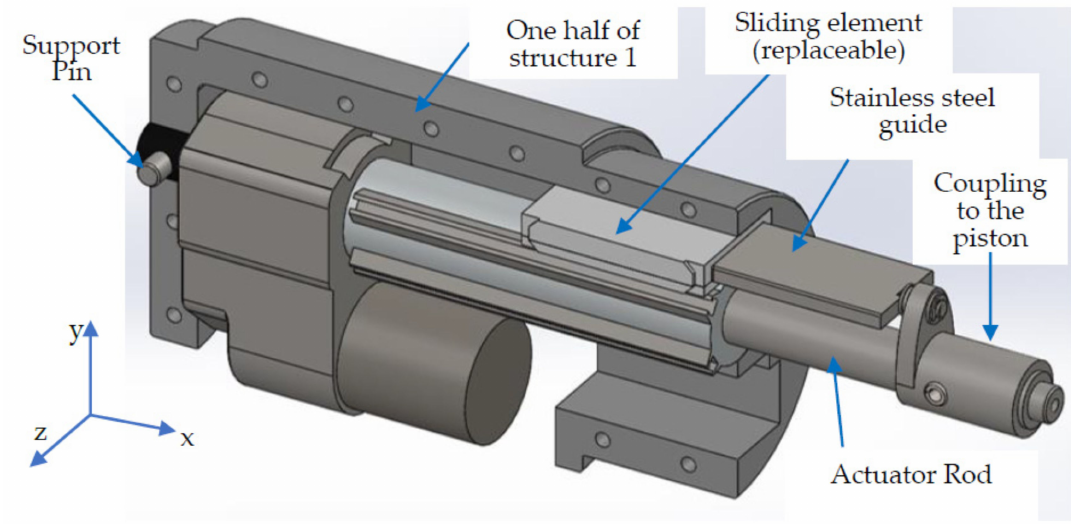
Figure 5. Detail of the structure designed to withstand the torque created by the actuator